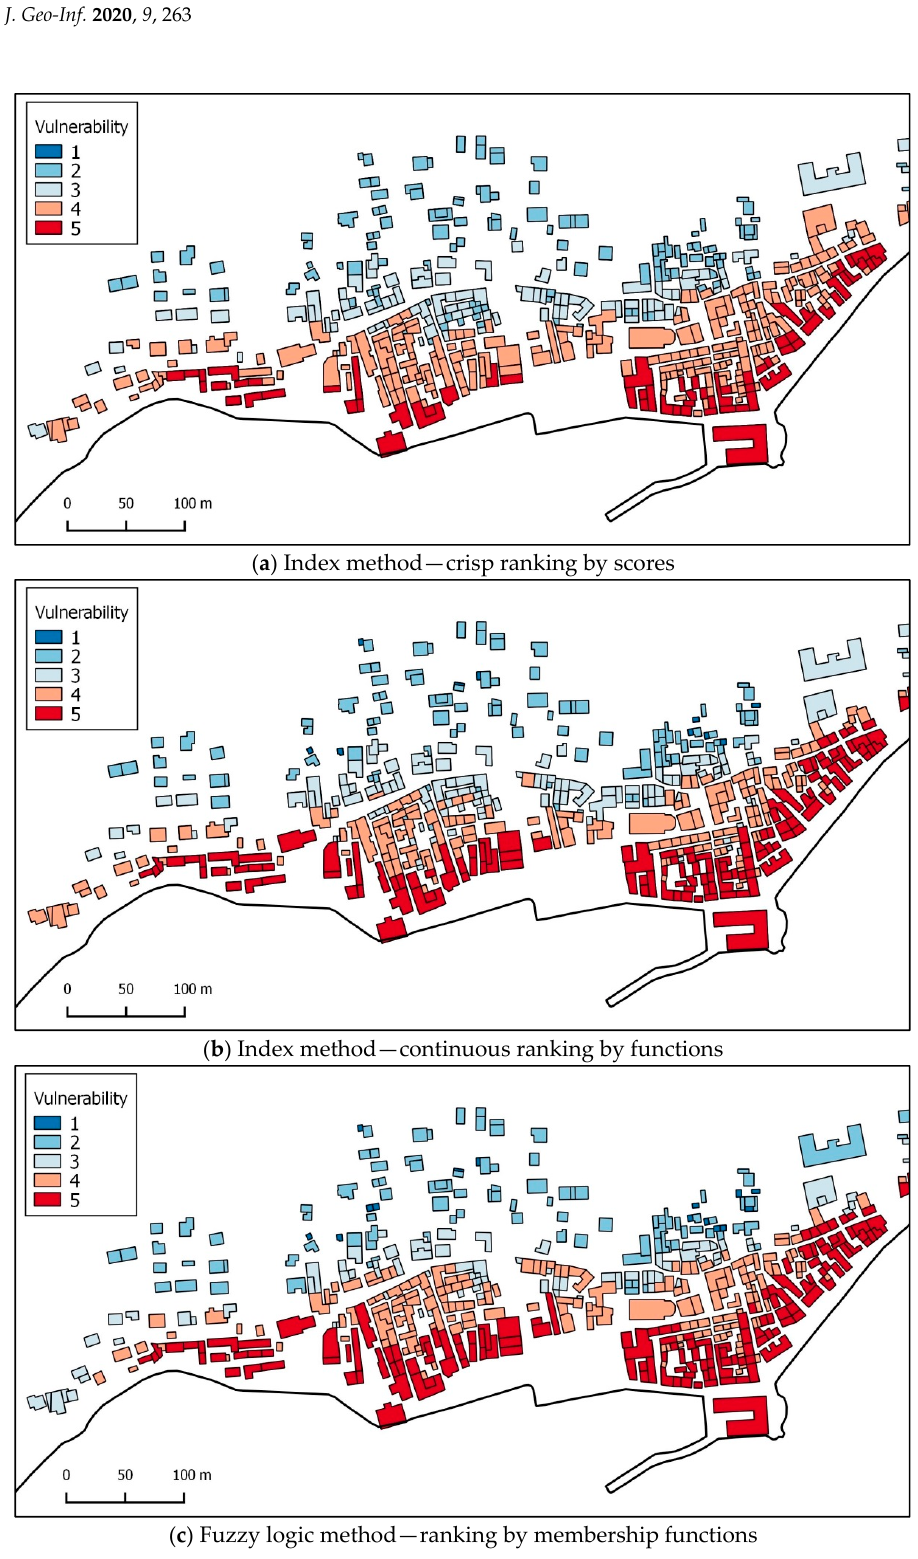
Figure 8. Maps showing the single vulnerability index for each building in the study area (an excerpt) calculated by the methods: ( a ) the Index method—crisp ranking by scores; ( b ) the Index method—continuous ranking by functions; and ( c ) the Fuzzy logic method—ranking by membership functions.